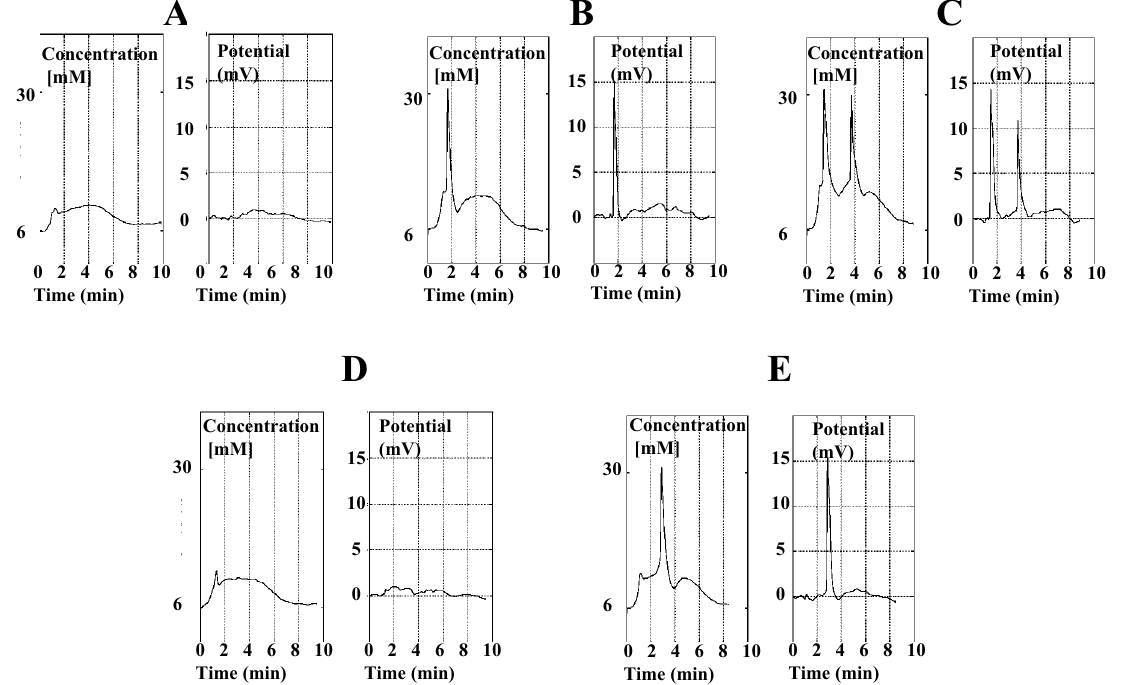
Fig. 3 – A, B and C are the response to exogenous potassium pulses of another slice. The interval between pulses was one hour. The concentrations used were A = 10 mEq/l, B = 12 mEq/l and C = 15 mEq/l. In D = 12 mEq/l and E = mEq/l, SS at 1 μ M was added to the pulse